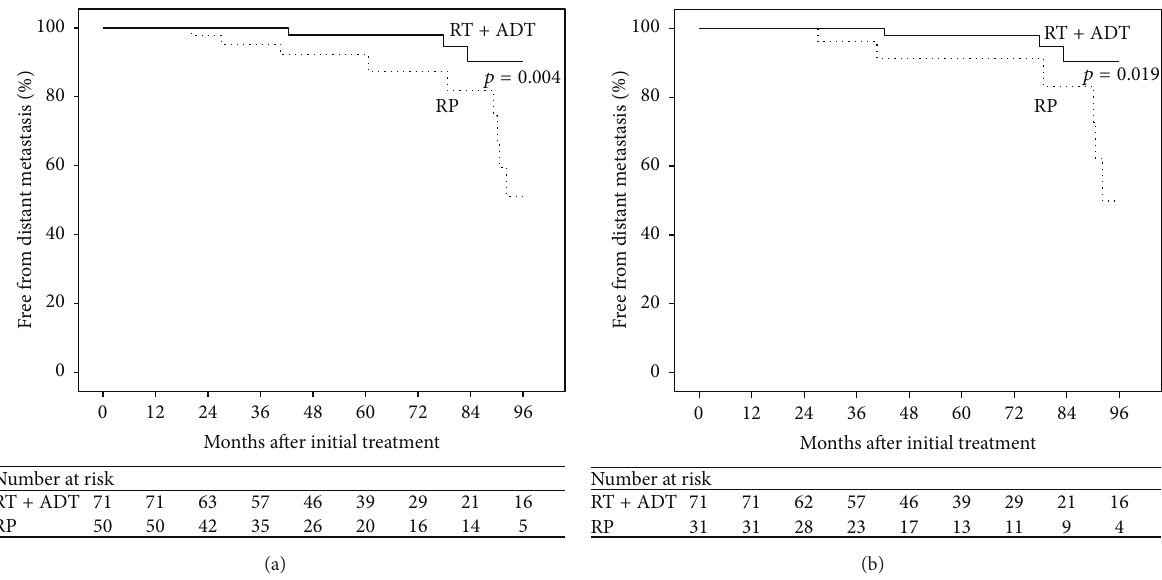
Figure 3: Kaplan-Meier estimate of freedom from distant metastasis in RT + ADT and RP patients with GS ≥ 8 on biopsy or pathology (a) and patients with GS ≥ 8 on biopsy (b).